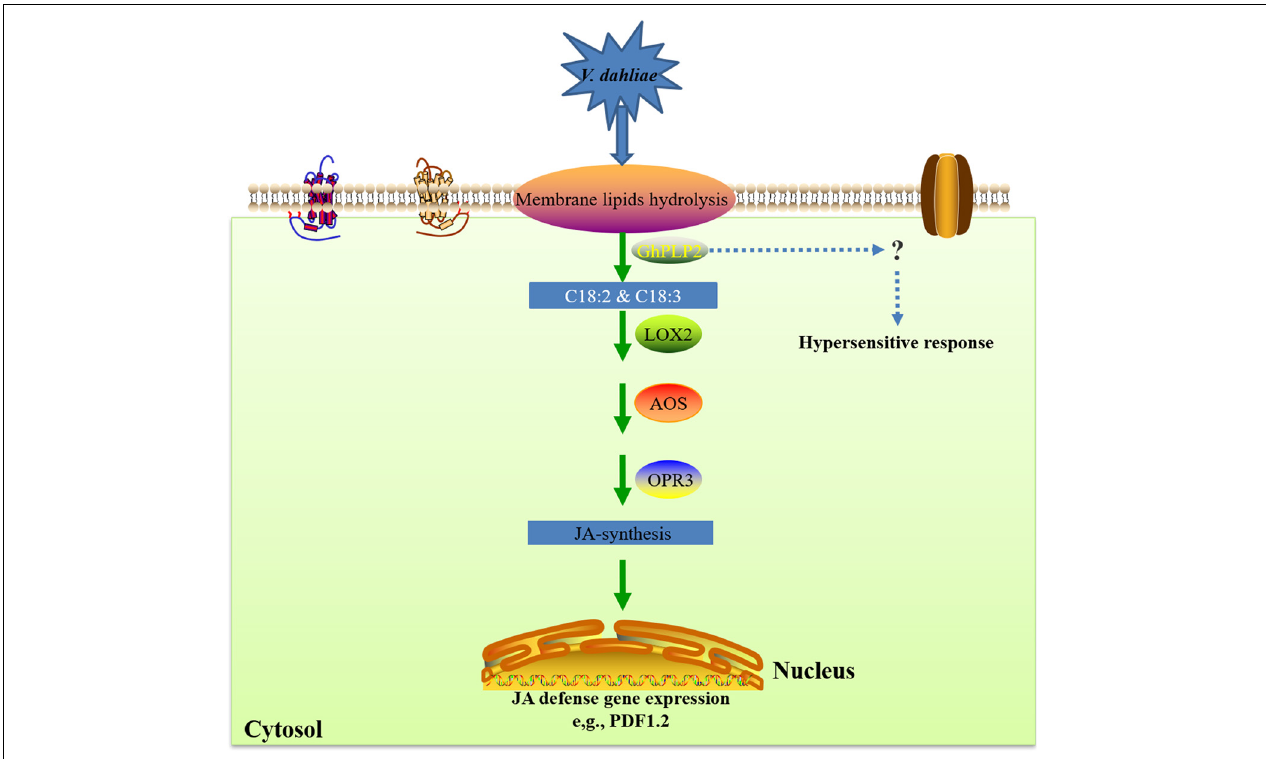
FIGURE 9 | A proposed model for the involvement of GhPLP2 in plant resistance against Verticillium dahliae . LOX, lipoxygenase; AOS, allene oxide synthase; OPR3, cis -(+)-12-oxo-phytodienoic acid reductase 3.